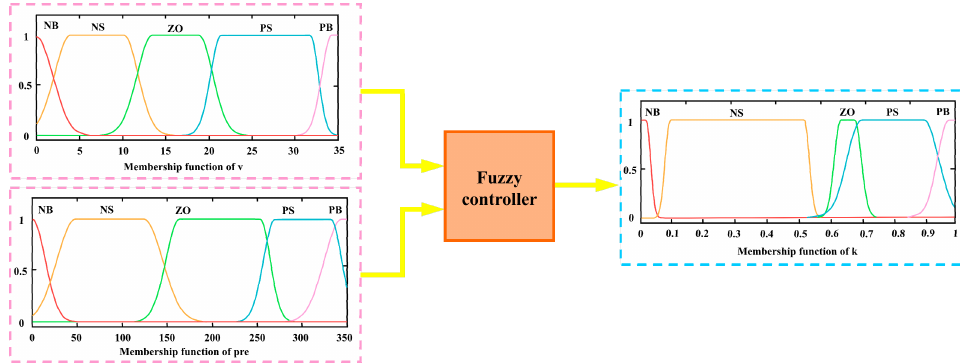
Figure 11. Membership function of input and output variables. Table 5. Fuzzy control rules.